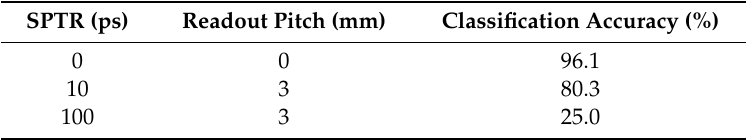
Table 2. Classification accuracy at representative conditions.